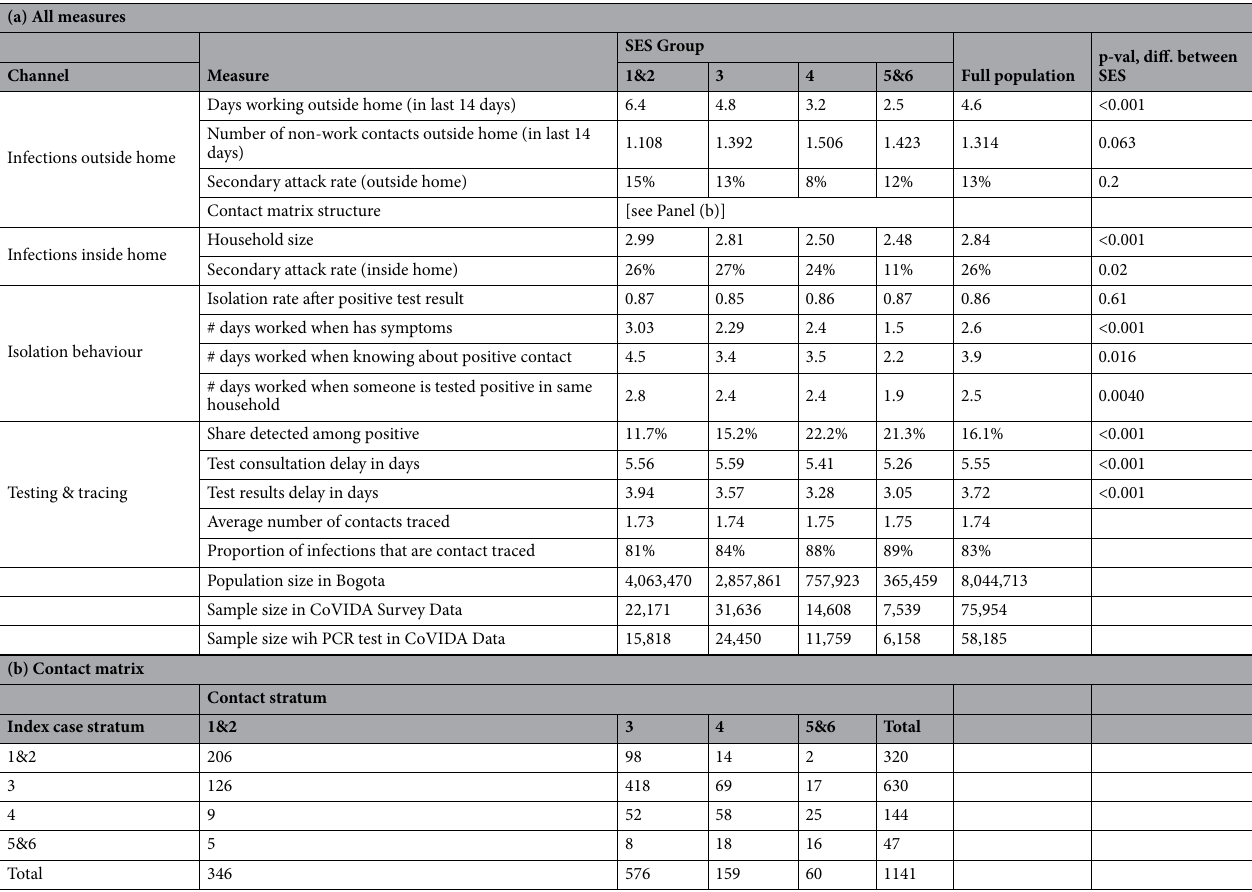
Table 1. Potential determinants of infection estimated by SES. Panel (a) : The table displays variables that capture various determinants of infection, sorted in four categories, followed by population and sample sizes. It provides the average value for each SES and for the population all-together. The last column presents the p-value of the F-test of difference between the 4 SES. A p-value below 0.05 means that one can reject at the 95% confidence level that the variable has population average that is equal for all SES (two-sided test). Standard deviations, Confidence Intervals, data sources and explanations of the calculation methods are presented in Table S7. Panel (b) : The contact matrix enumerates the number of cases for each possible of combination of stratum of the index case and its contacts. Positive cases in the CoVIDA study were traced, from this data, We use the self-declared stratum of the index cases and all their non-household contacts to count the number of contacts within each